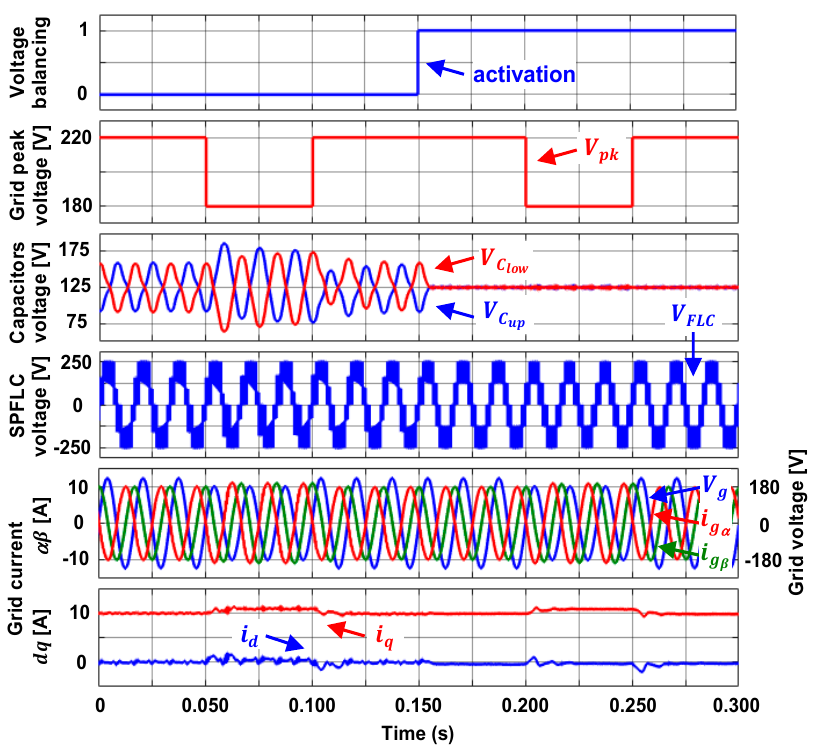
Figure 8. Performance of the voltage balancing strategy and the vector control for the proposed grid-tied SPFLC during a grid voltage sag/swell.